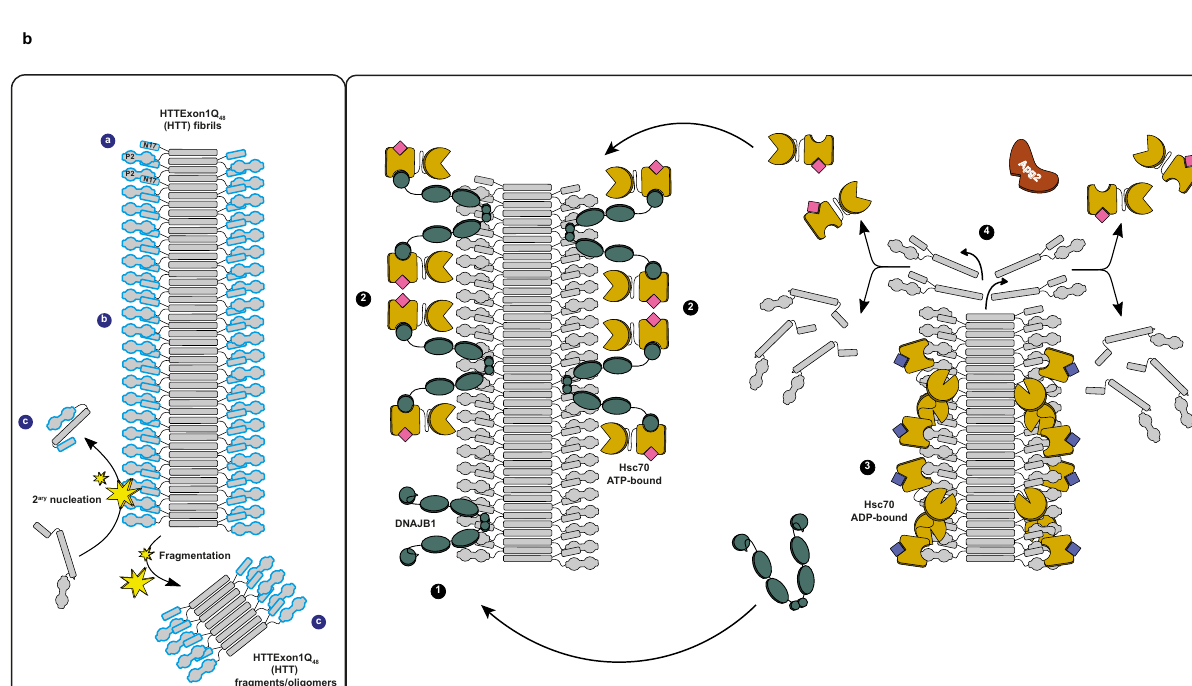
Fig. 10 | Model of suppression and disaggregation of HTTExon1Q 48 by the trimeric chaperone complex, Hsc70, DNAJB1, and Apg2. a Proposed model of the suppression of HTTExon1Q 48 aggregation by Hsc70, DNAJB1, and Apg2 +ATP. b Proposed modelofthe disaggregationof HTTExon1Q 48 fi brilsbyHsc70,DNAJB1,